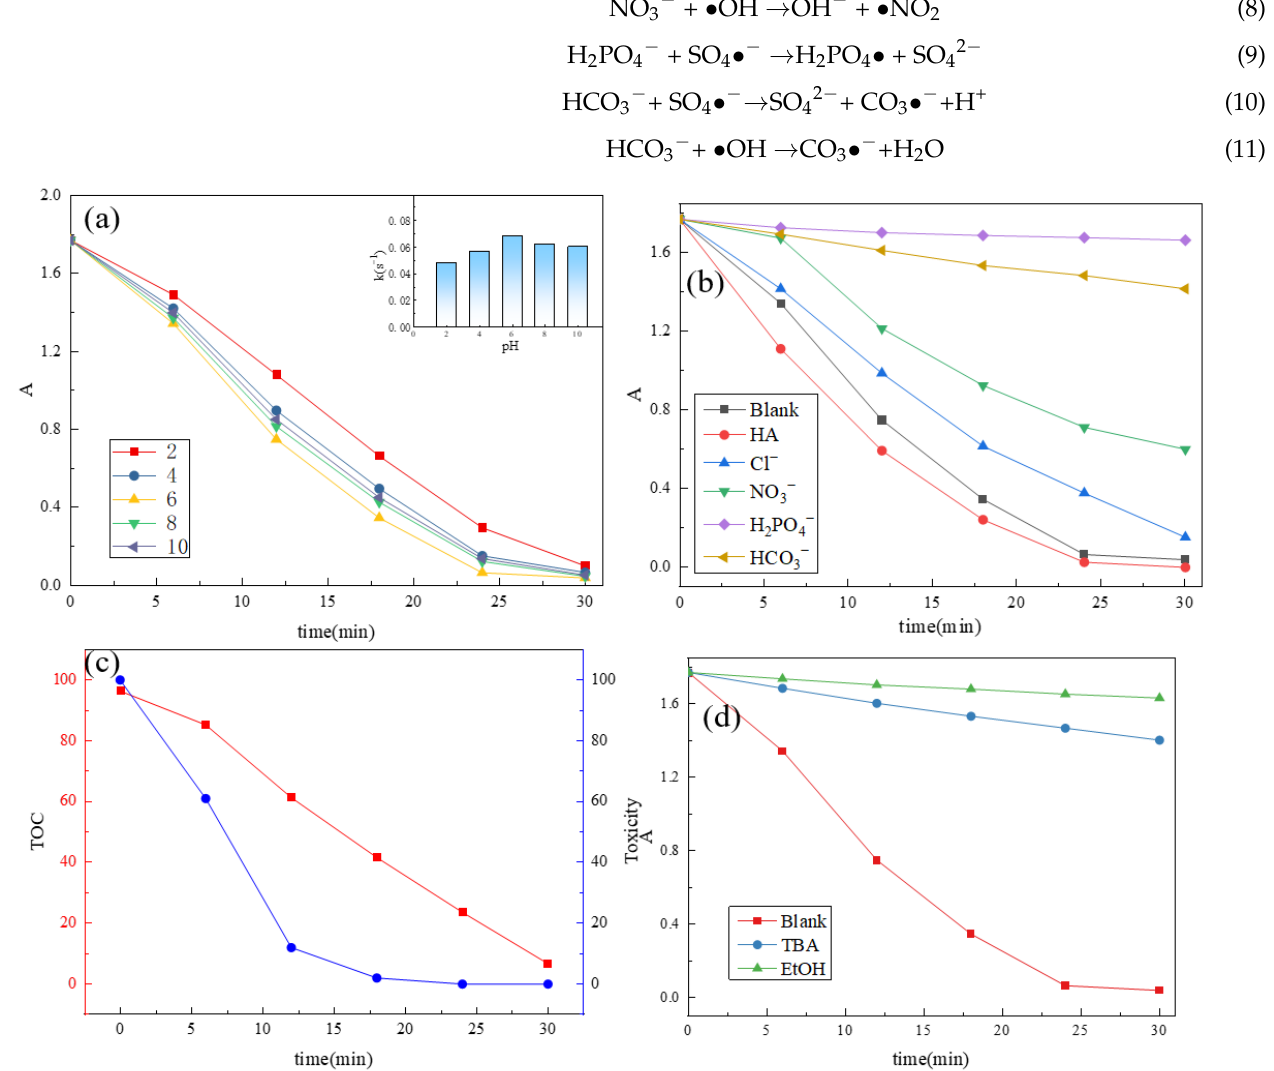
Figure 4. Different reactions’ initial pH in the system of NiFe 2 O 4 ( a ), the co-existing anions ( b ), TOC and toxicity analysis ( c ), and different inhibition experiments ( d ) (Reaction conditions: PS concentration = 0.4 g/L, catalyst dosage = 0.6 g/L, phenol concentration = 0.01 g/L, inhibition dosage = 50 mmol, reaction temperature = 25 °C and initial pH value = 6.5 (unadjusted)).